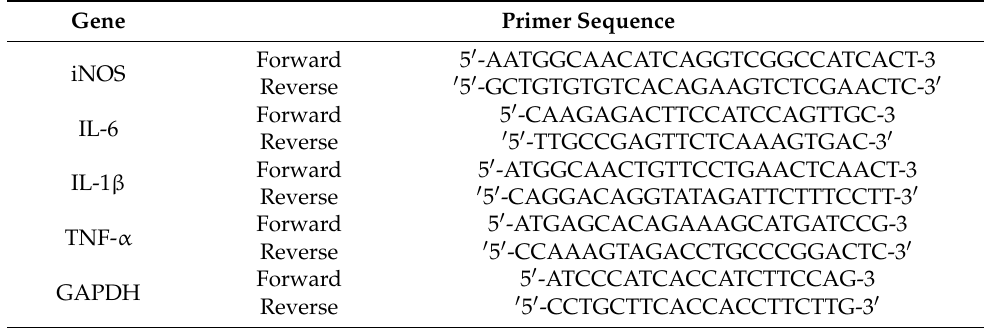
Table 1. Primer sequences for real-time